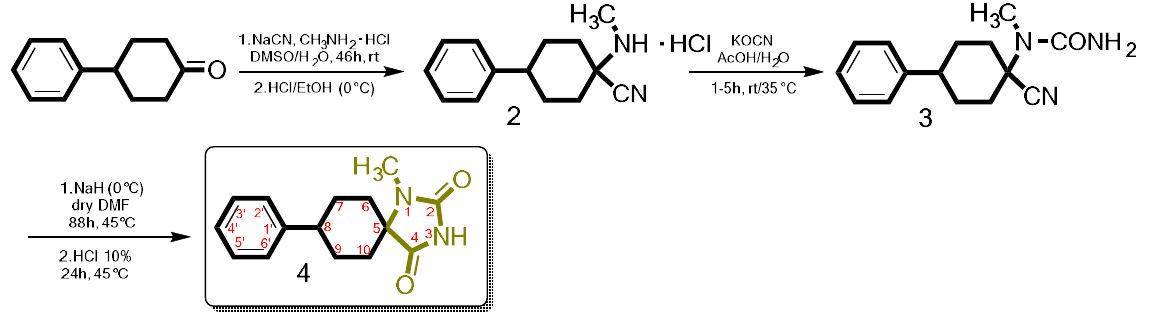
Figure 1. Chemical structures of hydantoin-containing compounds with important biological activity.